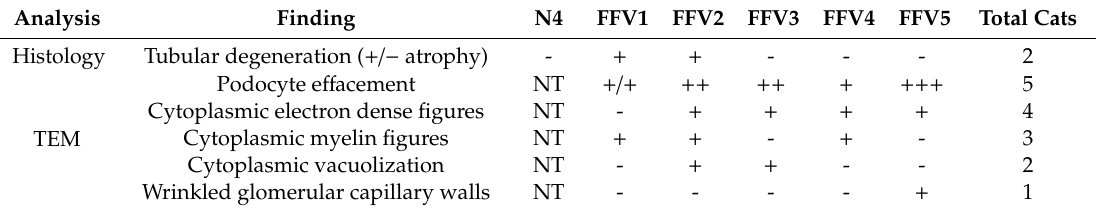
Table 4. Summary of pathological findings in glomeruli and tubulointerstitial compartment of control and FFV-infected cats. Kidney tissue was collected during necropsy on day 176 and submitted to the International Veterinary Renal Pathology Service for analysis. Cat FFV5 was on a di ff erent inoculation schedule than the rest of the FFV cats (Materials and Methods Section 2.2 and Figure 1).